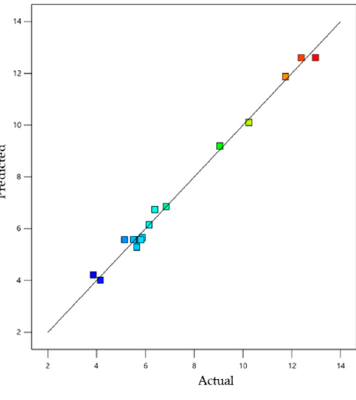
Figure 4. Linear correlation plot between actual and predicted values for loading capacity response (Y 2 ).